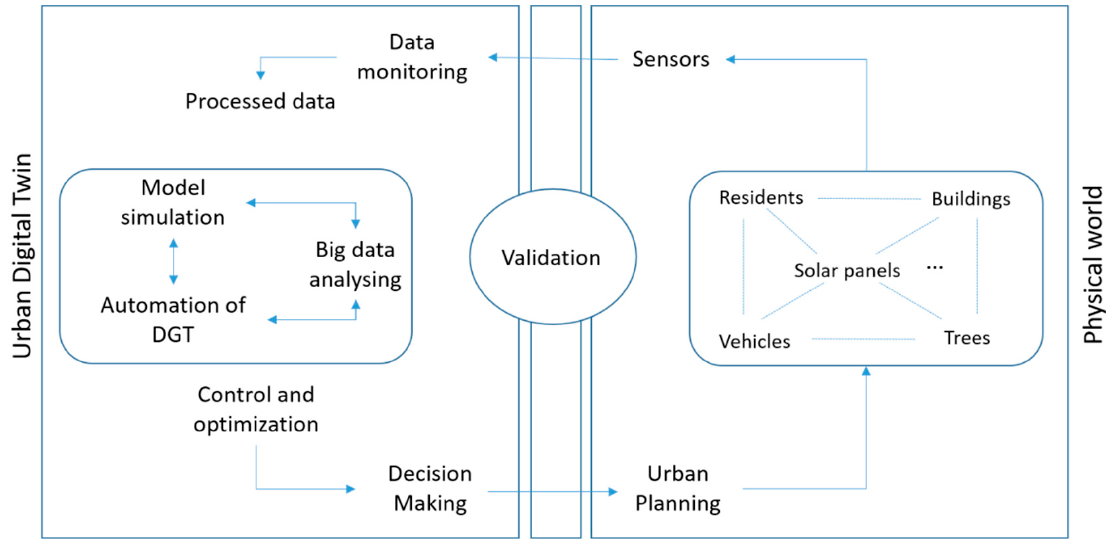
Figure 1. Conceptual Framework of an Urban Digital Twin .